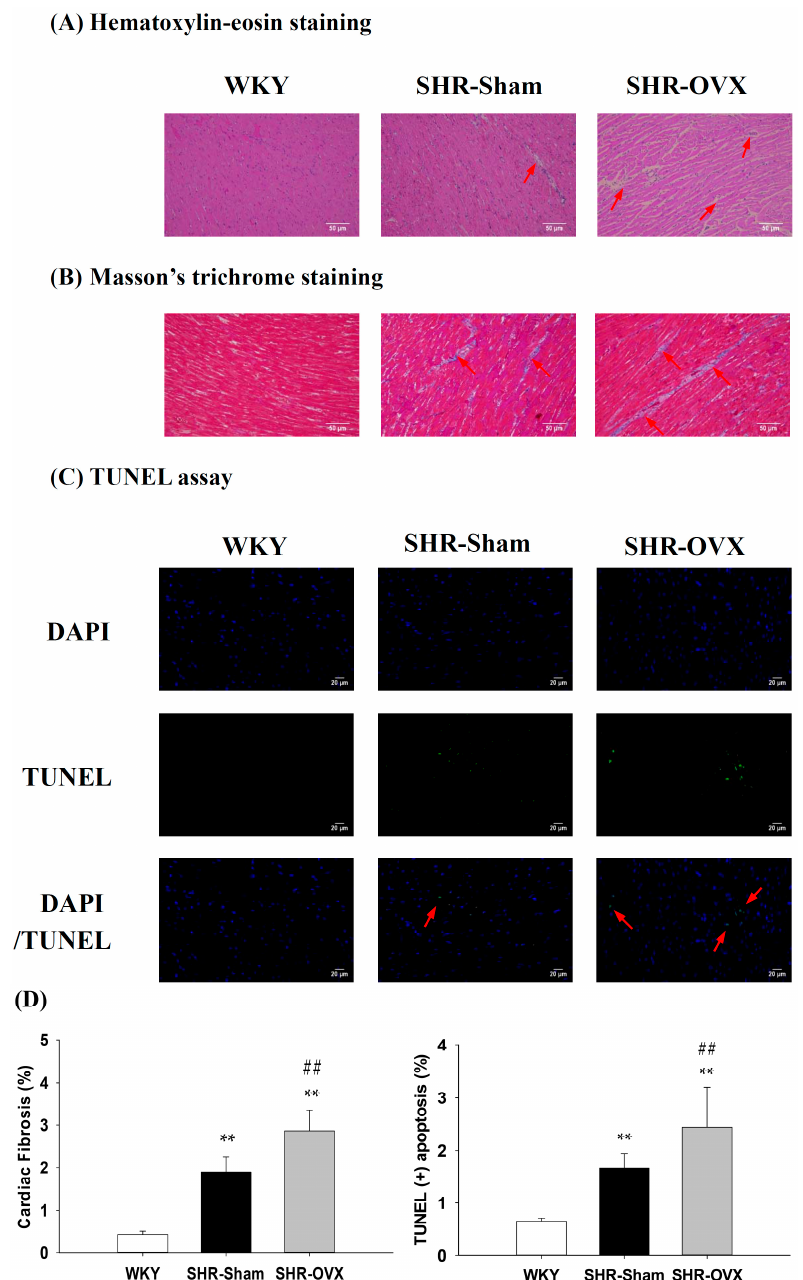
Figure 1. Representative histopathological analyses of cardiac sections from the left ventricles in the Wistar Kyoto rats (WKY), SHR with sham-operated (SHR-Sham) and SHR with bilateral ovariectomized (SHR-OVX) groups were performed with ( A ) hematoxylin-eosin staining (interstitial space: wide, arrows indicated) and ( B ) Masson’s trichrome staining (fibrosis: blue color, arrows indicated). The images of the myocardial architecture are magnified 200×; ( C ) Representative stained apoptotic cells of cardiac sections were performed by staining with 4,6-diamidino-2-phenylindole (DAPI) staining ( top , blue spots) and the terminal deoxynucleotidyl transferase dUTP-mediated nick-end labeling (TUNEL) assay ( bottom , green spots, arrows indicated) The images of myocardial architecture are magnified 400×; ( D ) The bar represents the percentage of the blue area to the field area in Masson’s trichrome staining, and the percentage of TUNEL apoptosis was expressed as the ratio of TUNEL-positive cells relative to total DAPI-stained nuclei and indicates mean values ± SD ( n = 6 in each group); ** p < 0.01 denotes significant differences from the WKY group; ## p < 0.01 denotes the significant differences between the SHR-Sham group and the SHR-OVX group.